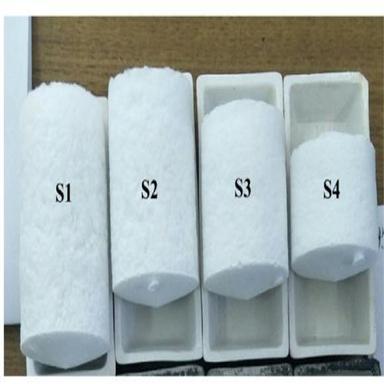
The prepared PFMs picture under different compressive percentages.